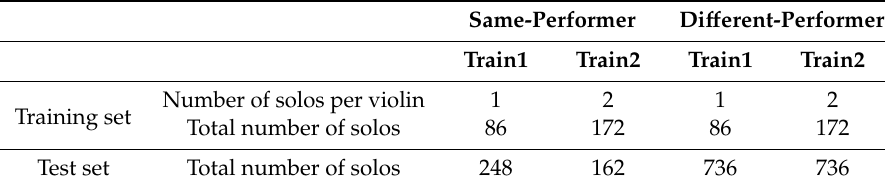
Table 10. Data partition of the two performer-based schemes.